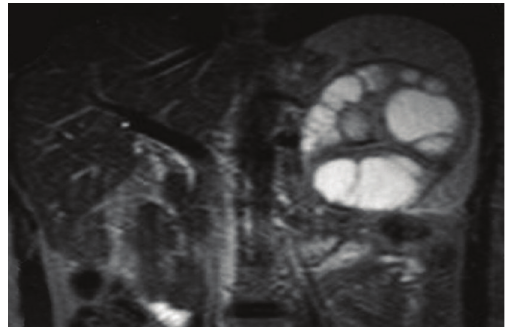
Figure 5: Coronal T2-weighted MRI shows multivesicular cystic lesion located in the middle and lower pole of the spleen, containing hypointense rim and